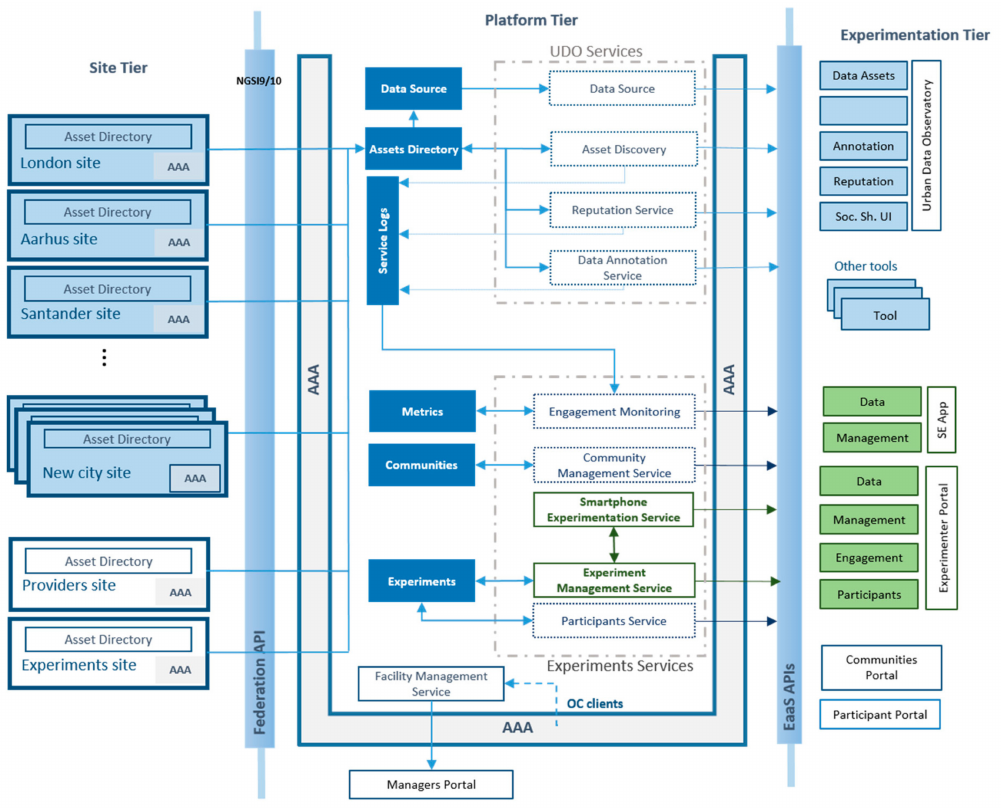
Figure 1. High-level architecture of OrganiCity and relation with the OrganiCity (OC) experimentation management